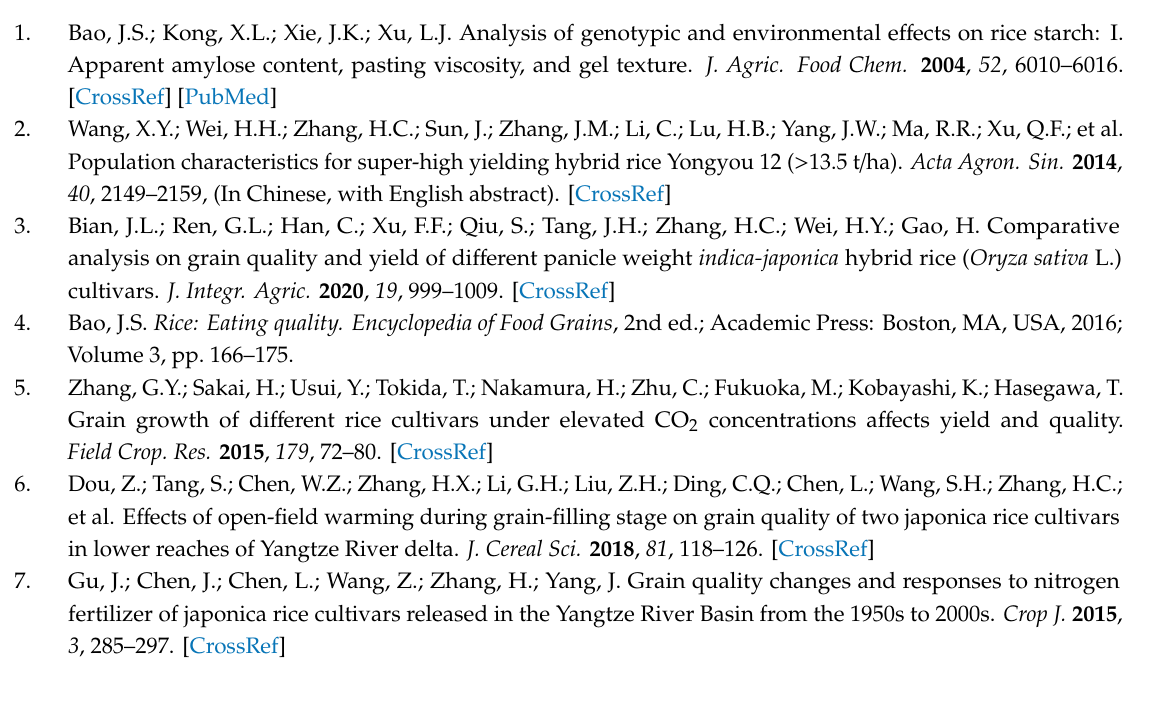
Figure S1: The hot paste viscosity ( A ), cool paste viscosity ( B ), appearance ( C ), hardness ( D ), balance ( E ), total protein content of superior and inferior grains under di ff erent nitrogen levels. YY12, Yongyou12; YY17, Yongyou17; SG, superior grains; IG, inferior grains; N0, control; LN, low nitrogen; MN, medium nitrogen; HN, high nitrogen; Di ff erent letters labeled on the columns in the same cultivar are significantly di ff erent ( p < 0.05); Figure S2: Comparison of brown rice appearance under di ff erent N levels. NRK, Normal rice kernel (in red rectangle); GRK, green rice kernel (in blue rectangle); DRK, died rice kernel, (in orange